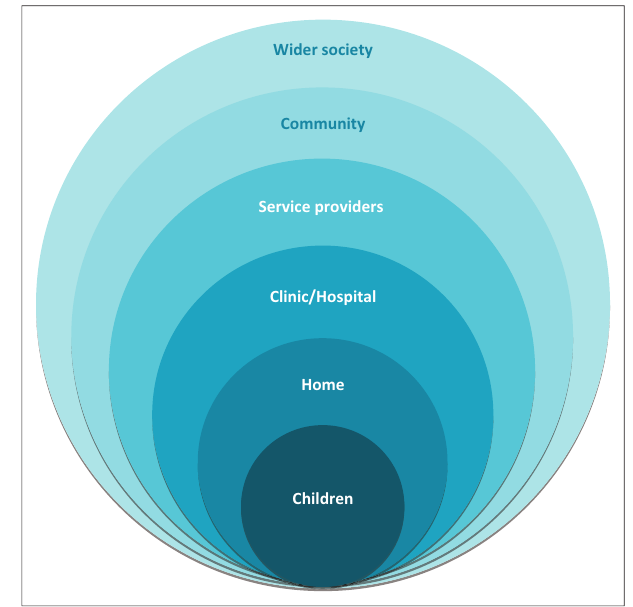
FIGURE 2: Strengthening circles of